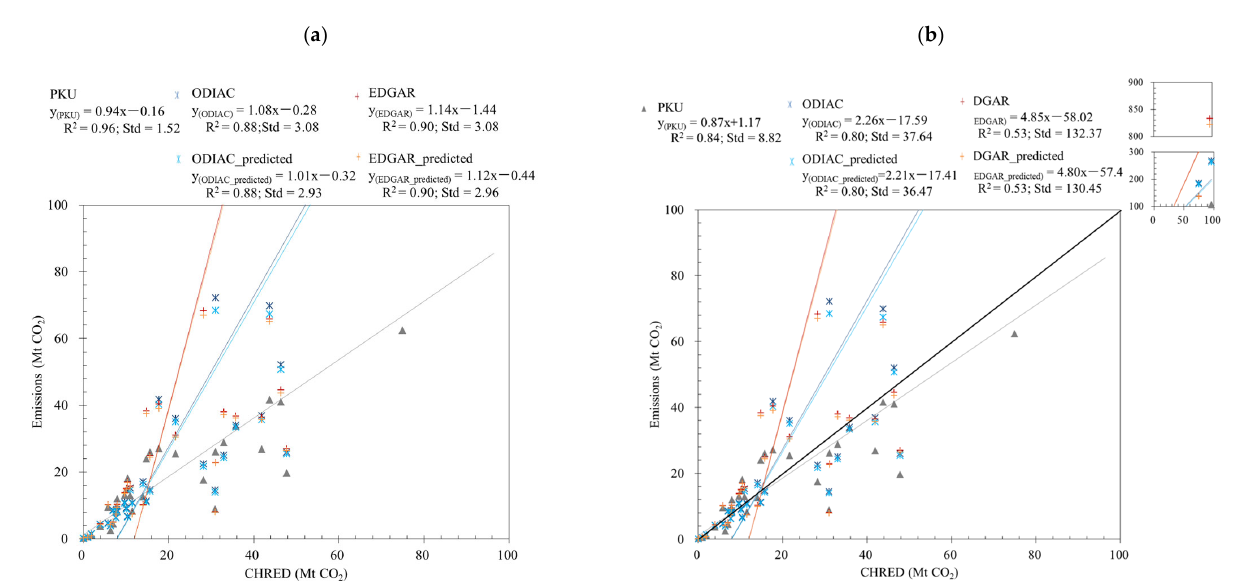
Figure 10. CHRED ( x -axis) in contrast to PKU, ODIAC, and EDGAR ( y -axis) based on regional mean Figure 10. CHRED (x ‐ axis) in contrast to PKU, ODIAC, and EDGAR (y ‐ axis) based on regional mean emissions in 2012 in China, in which ( a ) is the segementing-XCO 2 -based emissions which are from emissions in 2012 in China, in which ( a ) is the segementing ‐ XCO 2 ‐ based emissions which are from the clustering analysis of XCO 2 , and ( b ) is the province-based emissions which are averaged values the clustering analysis of XCO 2 , and ( b ) is the province ‐ based emissions which are averaged values for each province in for each province in China.